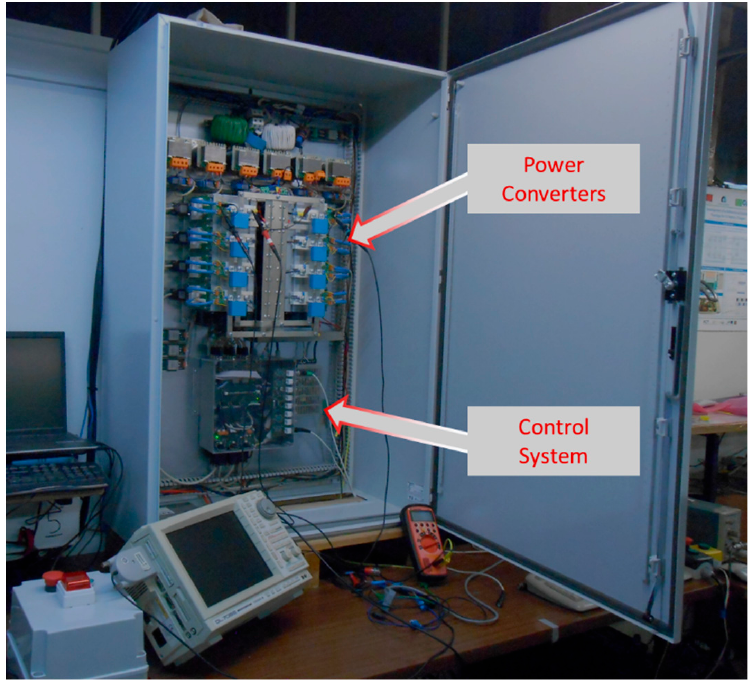
Figure 7. Laboratory prototype developed for the experimental validation.